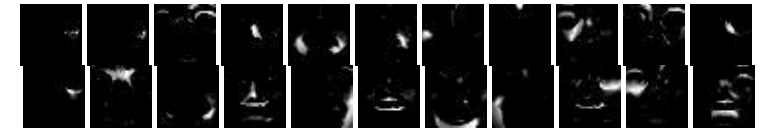
Figure 5. Features achieved by LNMF for JAFFE dataset.